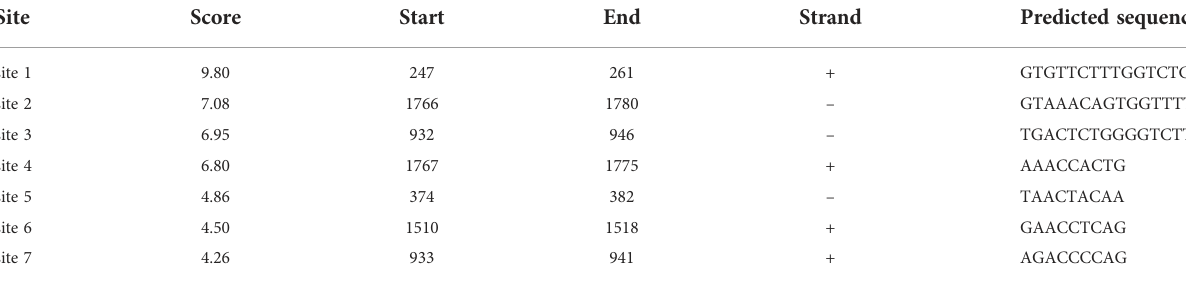
TABLE 1 RUNX2 binding motif prediction in MMP1